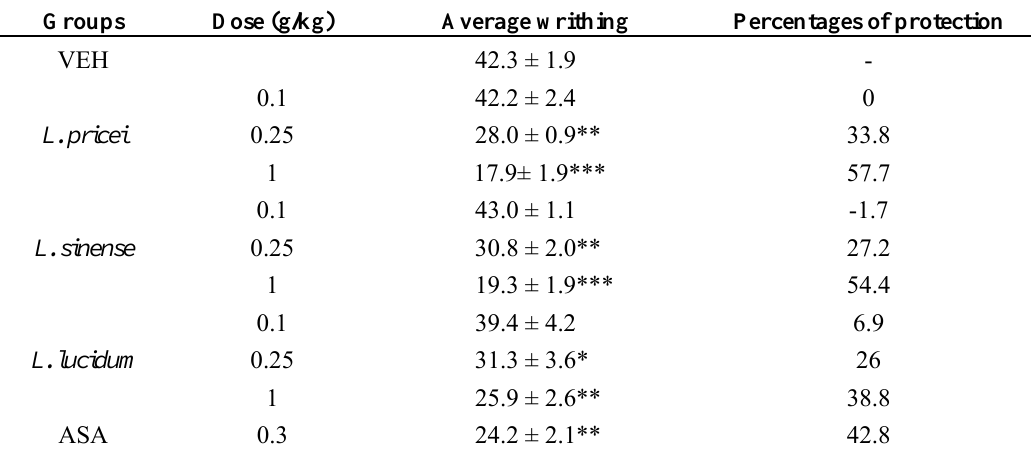
Table 1. Effects of methanol extract from Ligustrum plants leaves (0.1, 0.25, 1 g/kg) on acetic acid-induced writhing response in